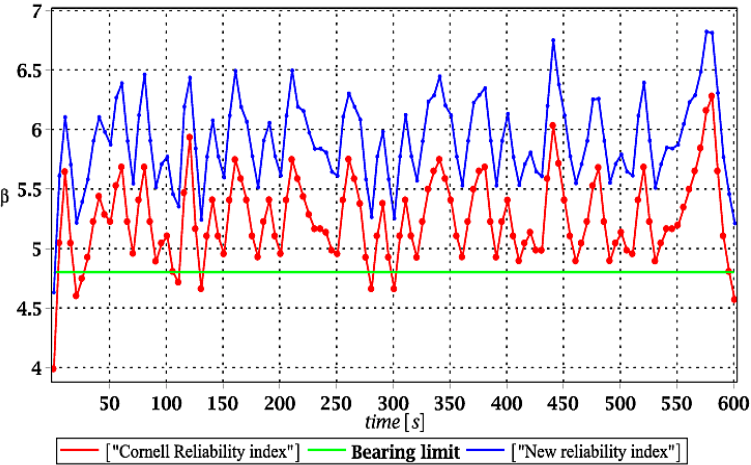
Figure 18. The comparison of dynamic reliability indices for uncertain Young’s modulus.